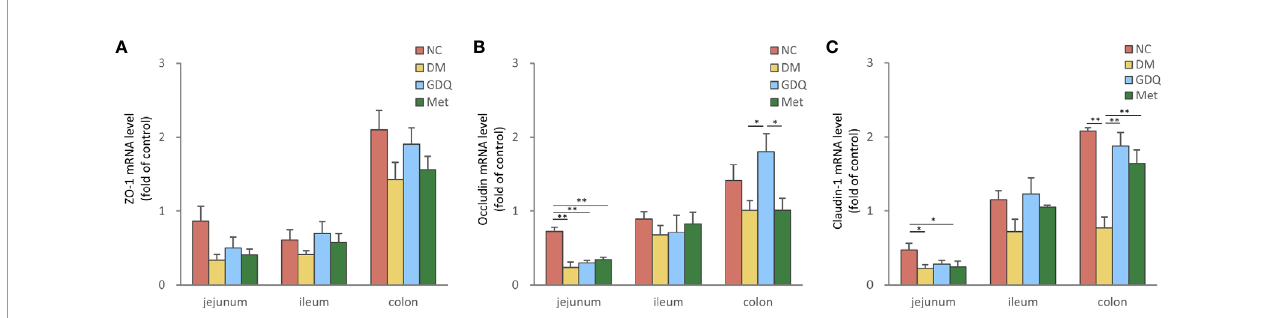
FIGURE 2 | GQD alleviated the intestinal barrier function of T2DM rats. Expression levels of (A) ZO-1, (B) occludin, and (C) claudin-1 in the jejunum, ileum, and colon after treatment for 12 weeks. Values are expressed as means ± SE. Differences were assessed by ANOVA: **p < 0.01, *p < 0.05. ZO-1: zonula occludens-1. The fold over control means the fold change differences relative to DM based on 2(-delta delta CT)